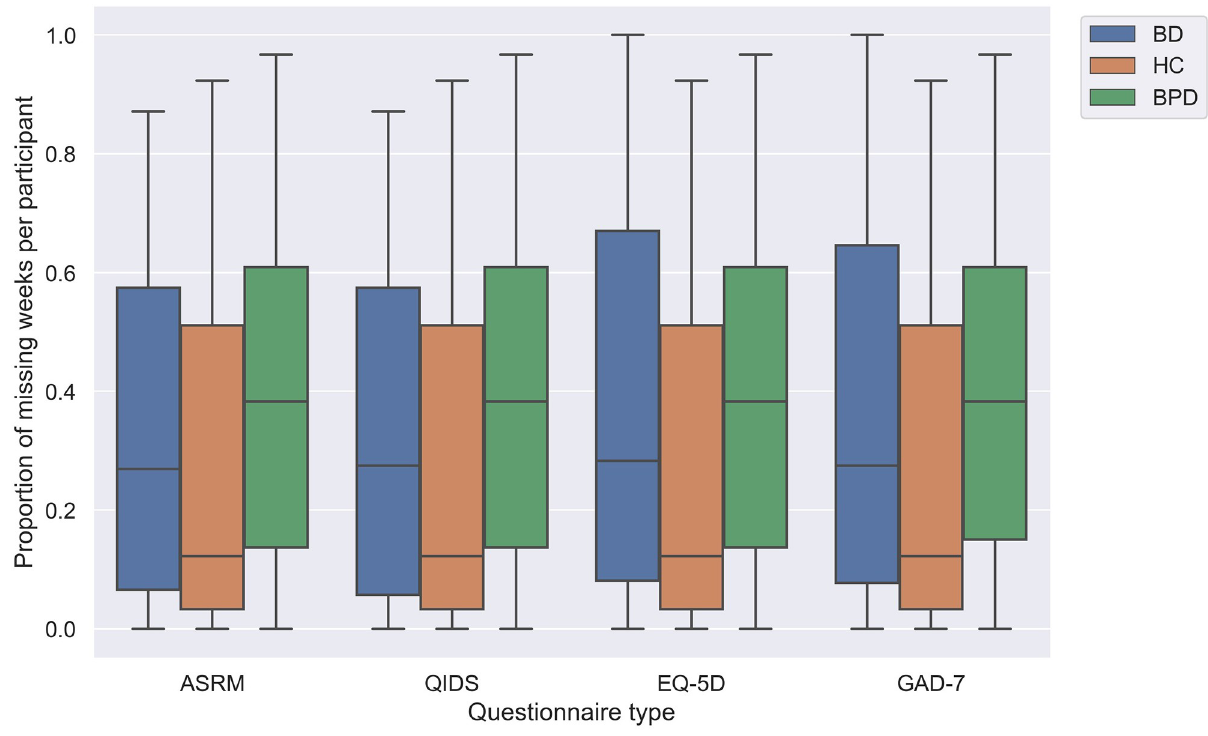
Fig 2. Boxplot: The proportion of missing responses per participant (median ± the interquartile range) in each of three diagnosis groups.